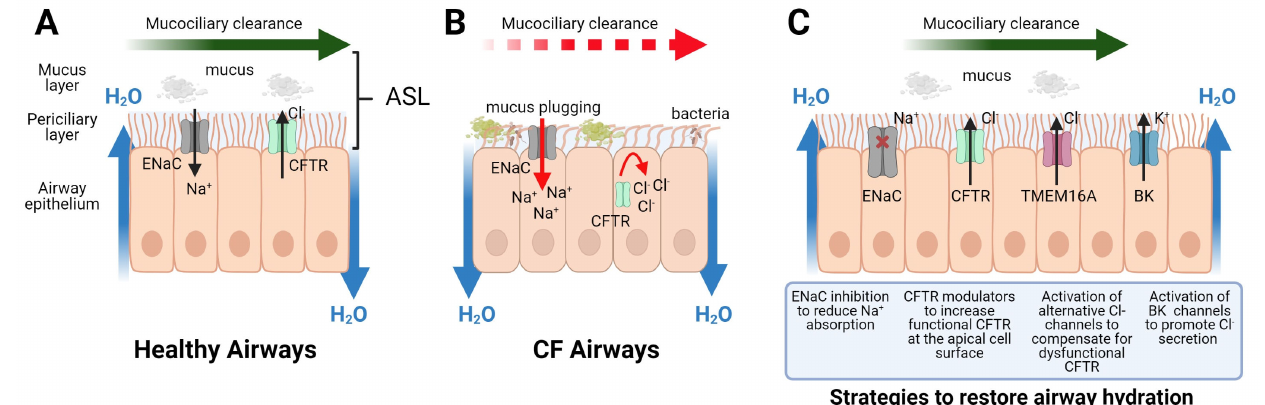
Figure 1. Modulation of ion transport in cystic fibrosis (CF) airways to restore the airway surface liquid. The airway surface liquid (ASL) comprises the watery periciliary fluid and overlying mucus layer that traps inhaled particles for removal from the lungs by mucociliary clearance (MCC). ( A ) In healthy airways, CF transmembrane conductance regulator (CFTR) and epithelial sodium channel (ENaC) work in concert to appropriately control the movement of Cl − and Na + , respectively, maintaining an optimal ASL and effective mucociliary clearance. ( B ) In CF airways, the loss of CFTR-mediated Cl − secretion and ENaC hyperabsorption results in the collapse of the PCL which restricts cilia function and MCC, resulting in mucus plugging and opportunity for bacterial colonisation. ( C ) A number of apically expressed ion channels may be targeted in CF airways to restore airway hydration. CFTR modulators (potentiator and/or corrector(s)) can partially restore CFTR-mediated Cl − secretion whereas inhibition of ENaC has potential to improve airway hydration, alone or in combination with CFTR modulator therapy. Additional strategies which include activation of TMEM16A, a CFTR- independent route to increase Cl − secretion, and activation of BK (big potassium) channels, offer further opportunity to improve airway